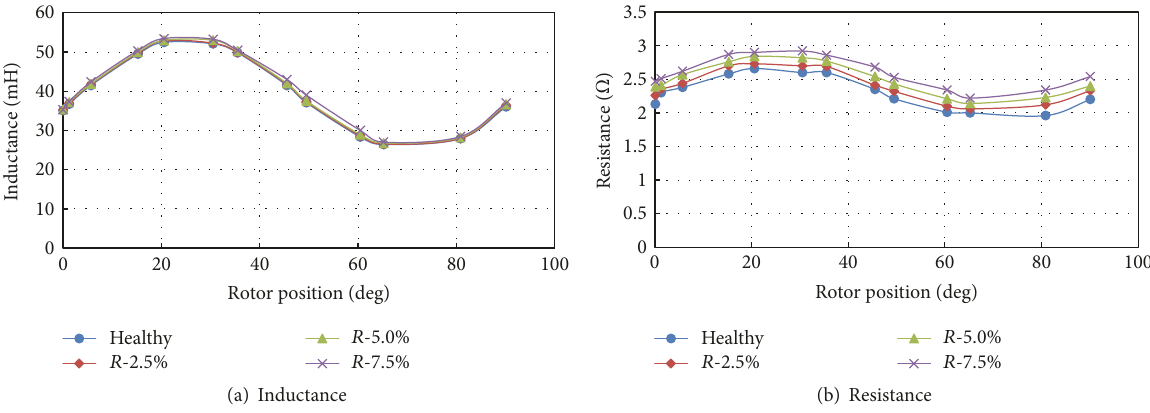
Figure 13: Measured impedance between 𝑢 and 𝑤 terminal at